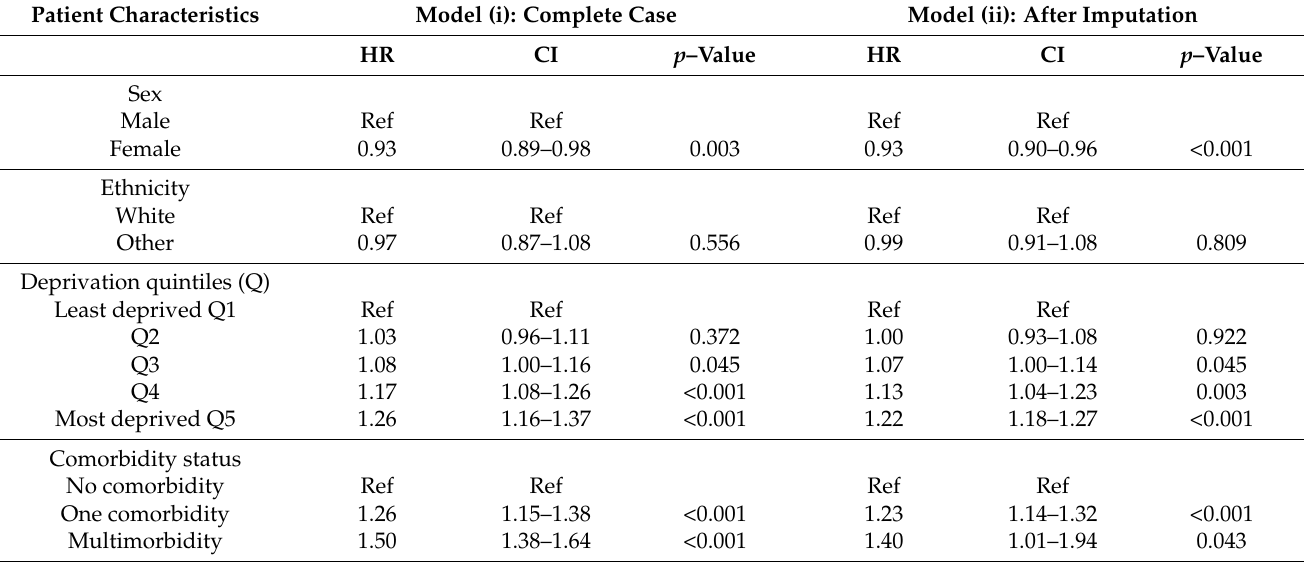
Table 2. Adjusted excess mortality hazard ratios for age, sex, deprivation, comorbidity, cancer subtype, route of diagnosis, ethnicity, and LSOA as random intercept for (i) complete case analysis, and (ii) after multiple imputation for patients ( n = 29,898) diagnosed with diffuse large B-cell lymphoma in England during the period